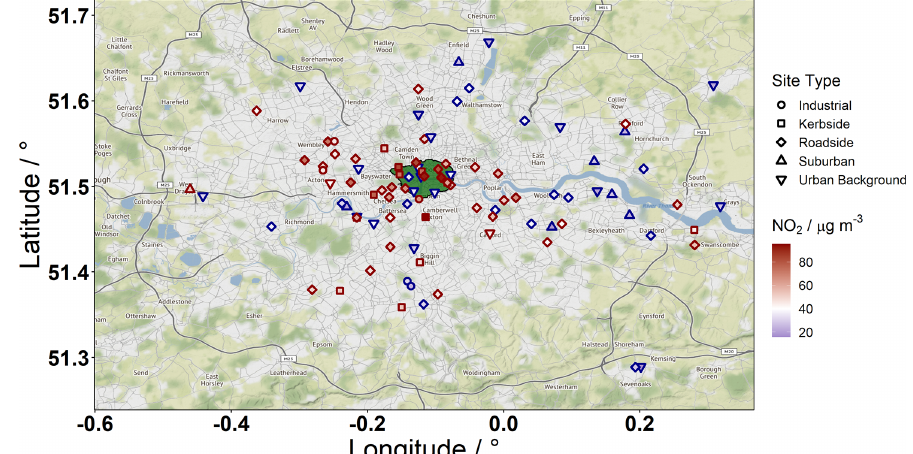
Figure 1. 101 air quality monitoring sites located in and around Greater London. Sites are coloured by their annual mean NO 2 concentration for 2017 (µgm − 3 ). Point shape denotes the type of measurement site. Point borders change from blue to red above the 40µgm − 3 air quality limit. 57 sites had annual mean concentrations above this limit in 2017. The area which encompasses the congestion charging zone and ultra- low emissions zone is shown in green. Map tiles by Stamen Design, under CC BY 3.0. Data © OpenStreetMap contributors 2021. Distributed